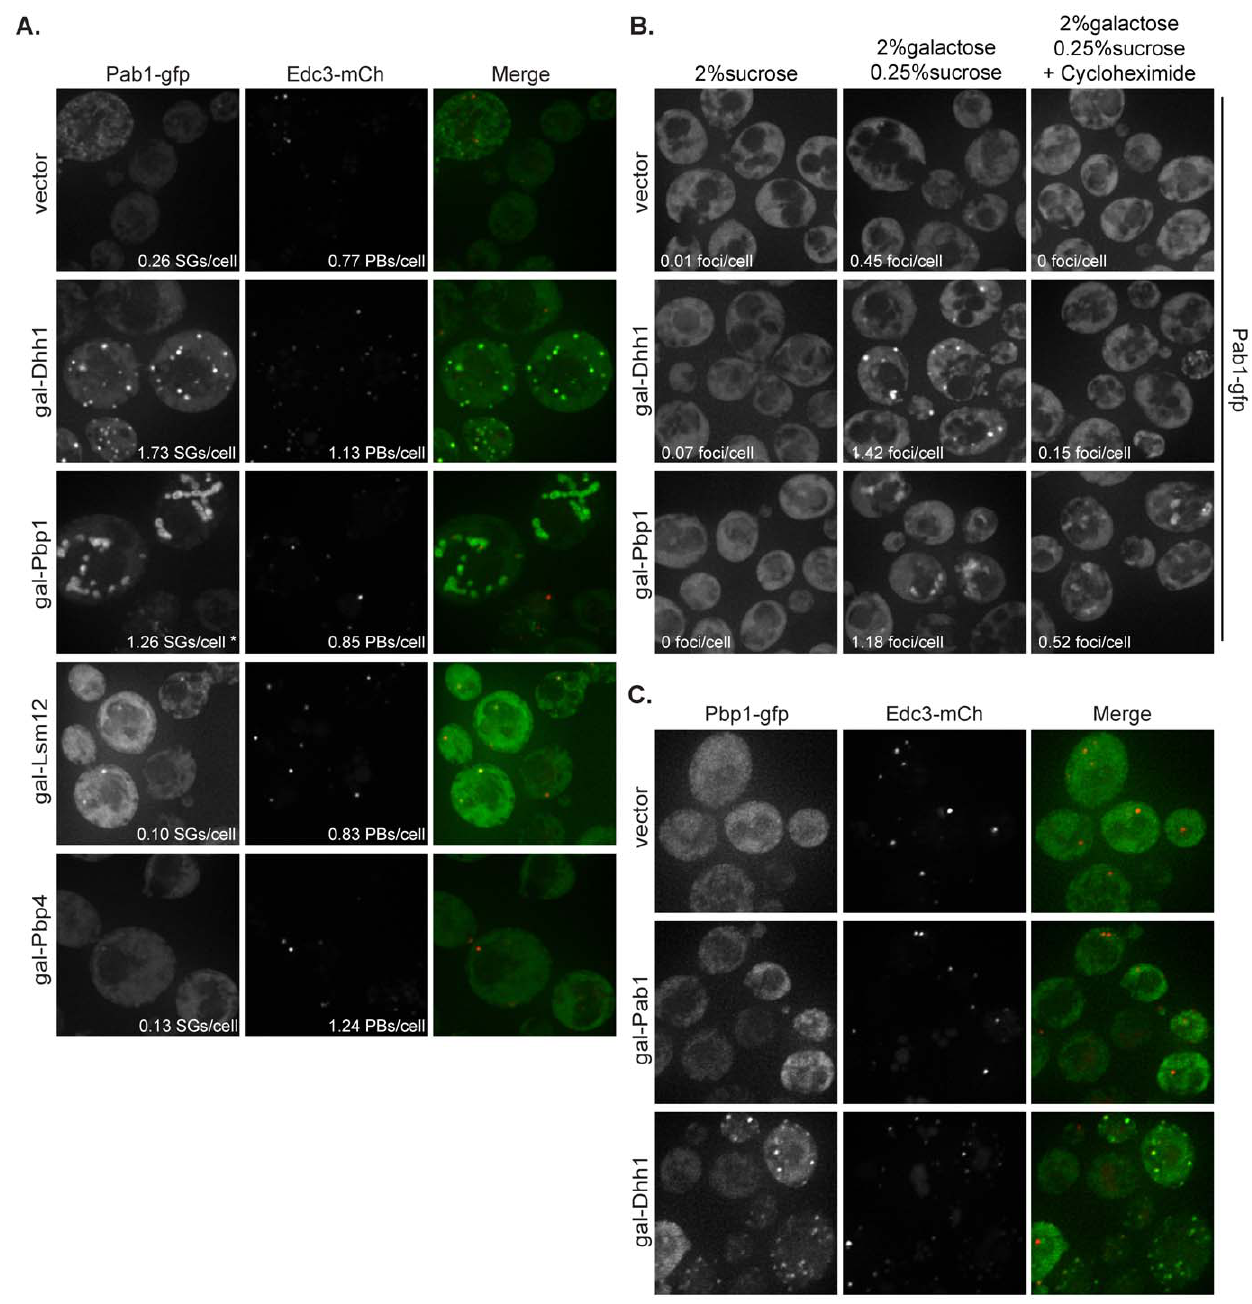
Figure 6. Dhh1 and Pbp1 over-expression trigger Pab1 granule formation in the absence of stress. Proteins were expressed under galactose-inducible promoters on high copy plasmids in wild-type cells. (A) Cells were assayed for their ability to form P-bodies (Edc3-mCherry) or stress granules (Pab1-GFP) in media containing 2% galactose with 0.25% sucrose. (B) Granules triggered by Dhh1 over-expression are dependent upon actively translating mRNAs. Addition of 100 m g/ml cycloheximide for 30 minutes to block translation following two hours of galactose induction substantially reduced Pab1 foci formation in cells over-expressing Dhh1, while only slightly reducing Pab1 foci in cells over-expressing Pbp1. (C) Pab1 over-expression does not cause granule formation as assessed by the P-body marker, Edc3, and the stress granule marker, Pbp1, in media containing 2% galactose with 0.25% sucrose. (*) denotes underestimate of Pab1 foci due to large string-like aggregation.